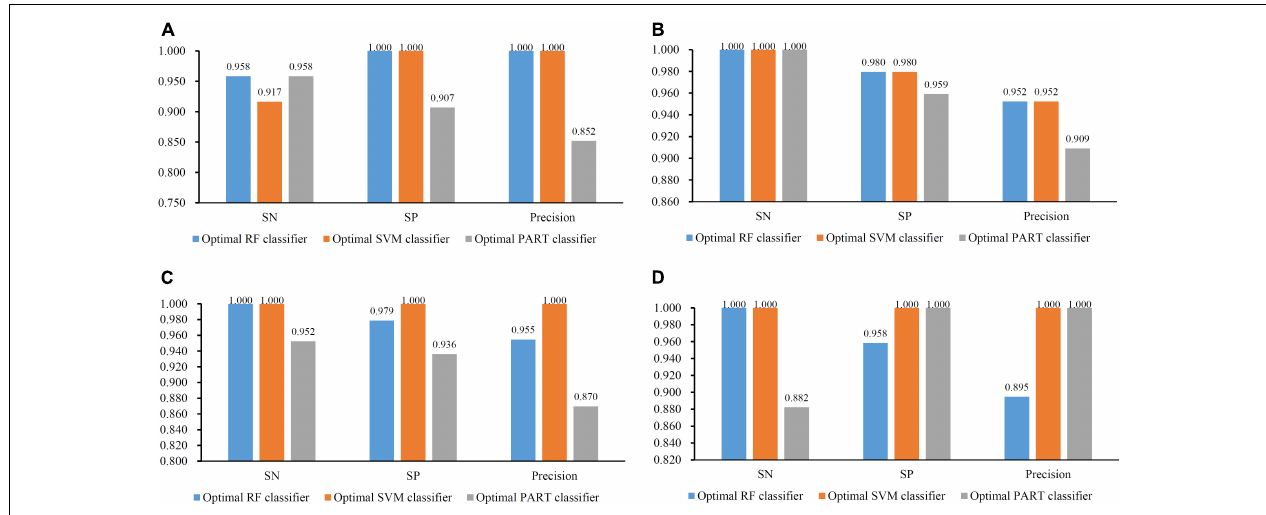
FIGURE 3 | Bar chart to show three measurements of the optimal classifiers on four brain structures. (A) CRB brain structure; (B) ERC brain structure; (C) DLPFC brain structure; and (D) HIPPO brain structure. The optimal PART classifier generally provided the lowest performance.